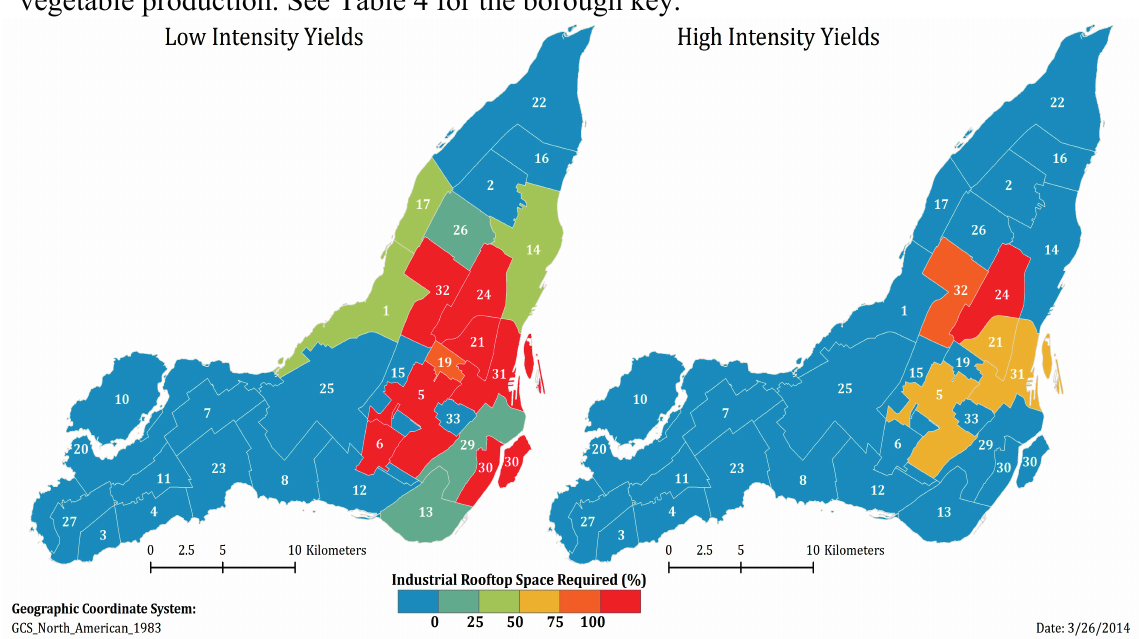
Figure 3. The percentage of industrial rooftop space needed to produce hydroponics after maximizing the use of vacant and residential yard space for low-intensity or high-intensity vegetable production. See Table 4 for the borough key.